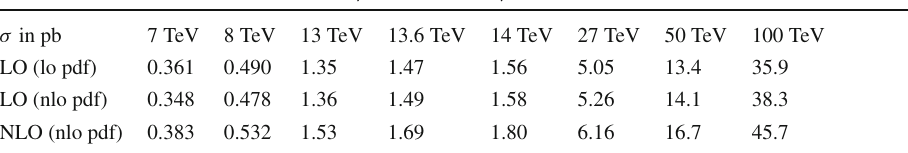
Table 6 The ¯ tq γ cross sections (in pb, with μ = m t , p γ T >